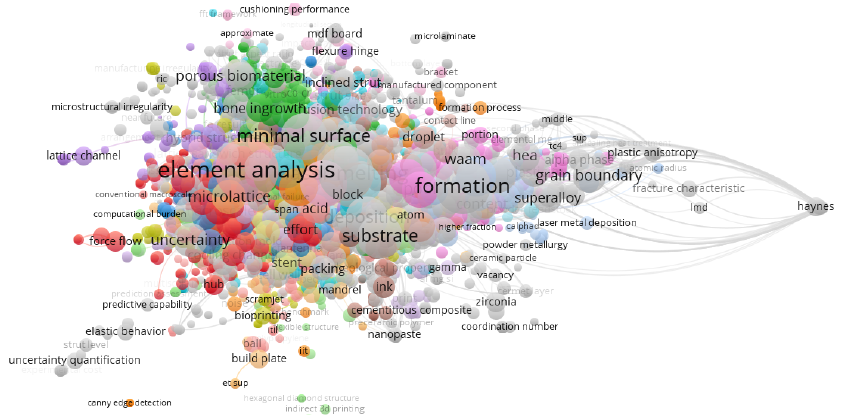
Figure 13. Visualization of a network for keywords published in articles on “additive manufacturing on lattice structure” research (data retrieved from the WoS database on 20 June 2022 and visualized with VOSviewer).